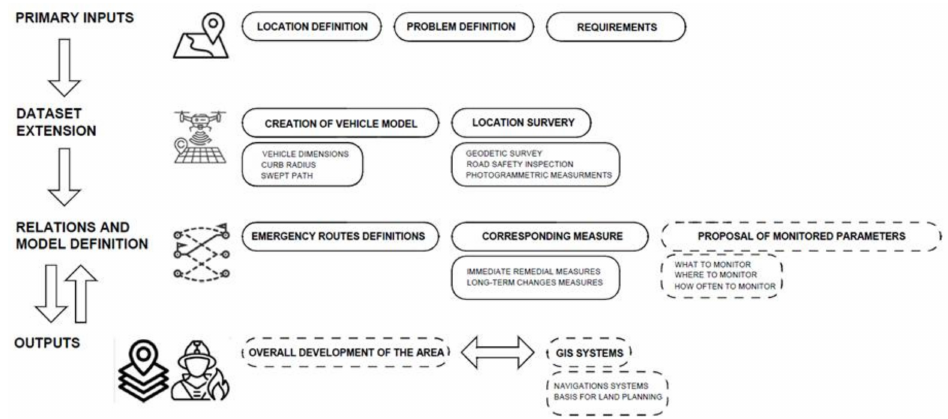
Figure 1. Diagram of the generalised procedure